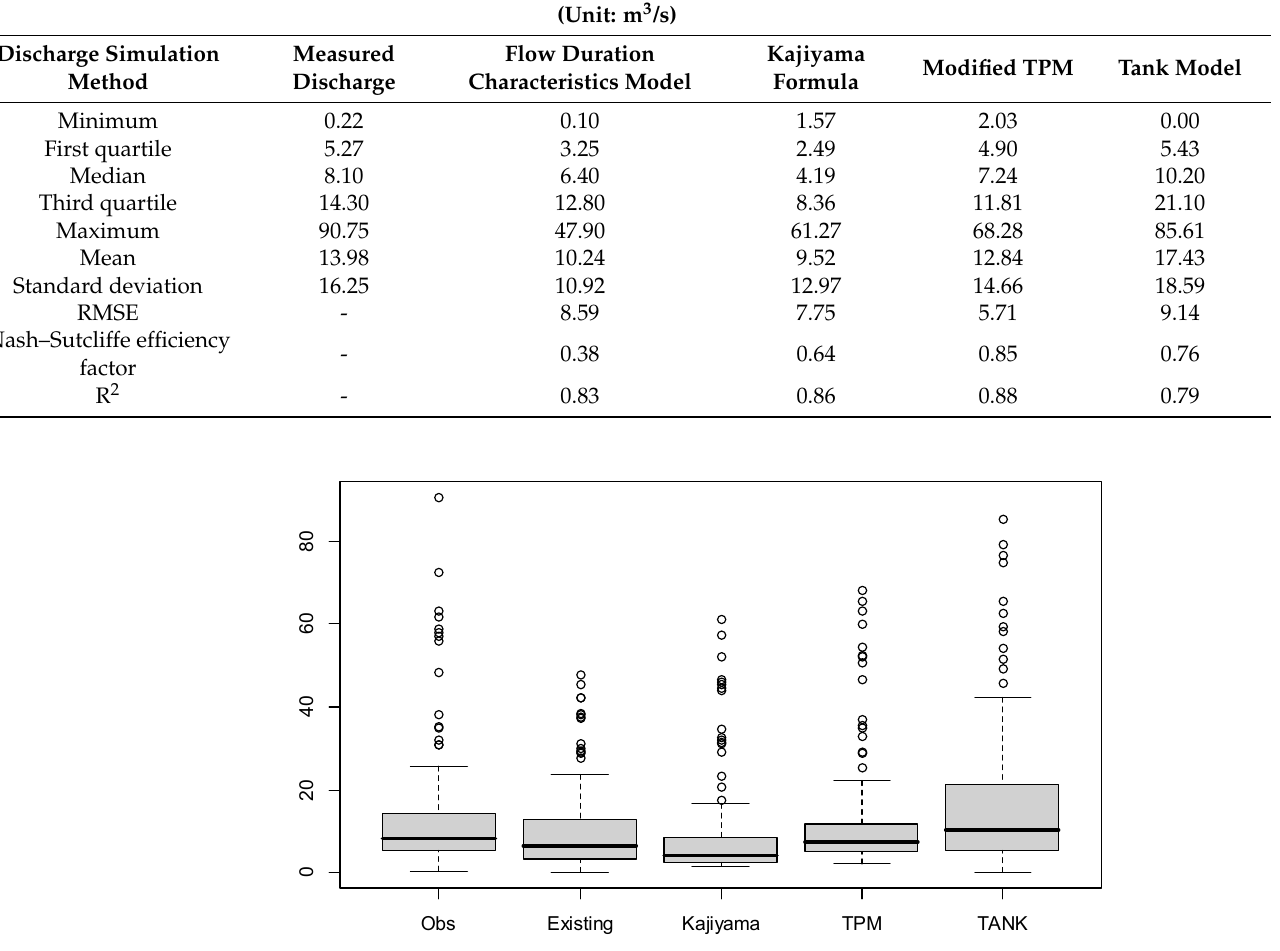
Figure 4. The distributions of the simulated and measured monthly average discharge by the Figure 4. Th e distributions of the simulated and measured monthly average discharge by the simulation method for the Socheon SHP plant (unit: m 3 simulation method for the Socheon SHP plant (unit: m (cid:2871) /s ).